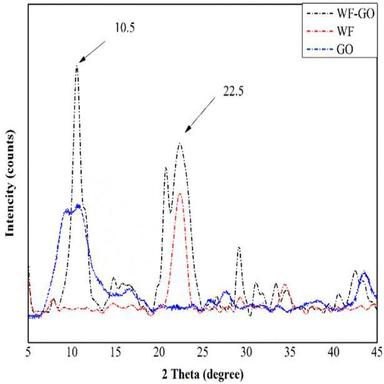
XRD pattern of WF, GO and the WF/GO hybrid.